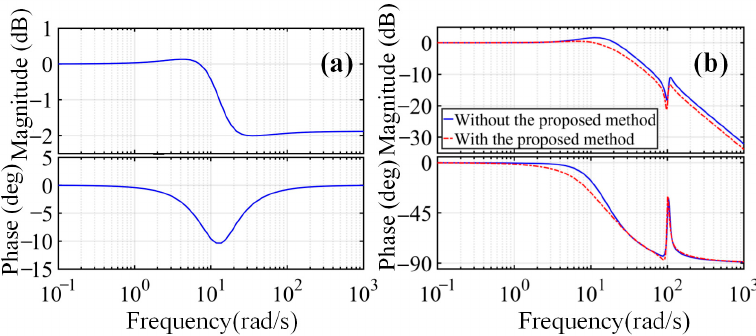
Figure 12. FDC adjustment of the proposed adaptive fractional-order anti-saturation method: ( a ) fractional-order FDC planning target for the voltage amplitude characteristic; ( b ) FDC comparison of the two motor systems with and without the proposed method.